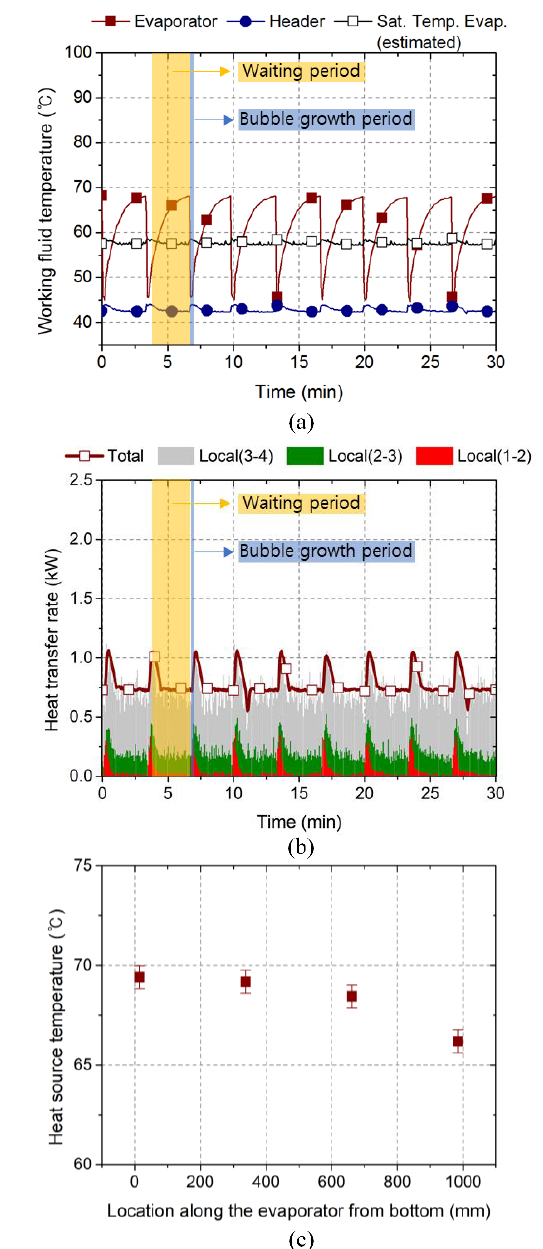
Figure 14. Operating characteristics of an FHP with a heat source temperature of 69.0 °C: ( a ) working fluid temperature, ( b ) cumulative heat transfer rate, and ( c ) local heat source temperature.